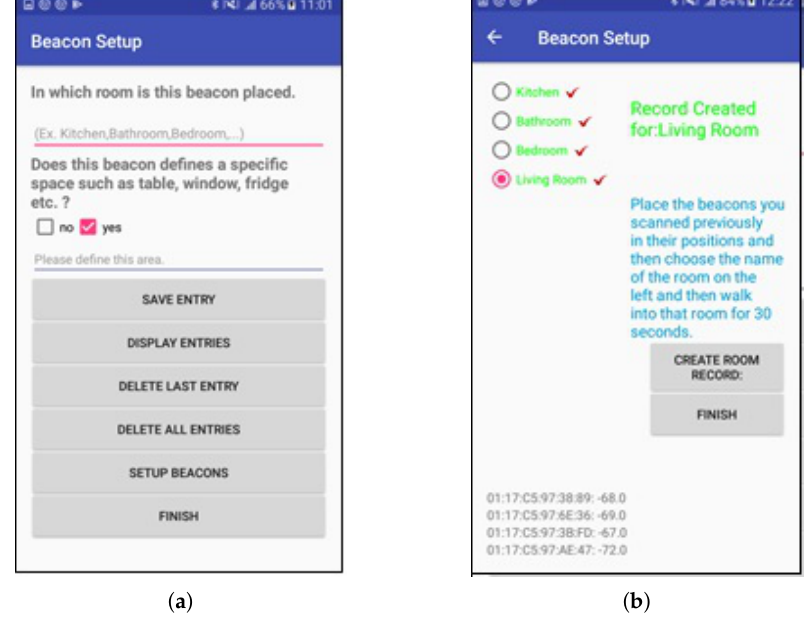
Figure 6. Screenshots from the Beacon Setup application ( a ): The user enters the names of the rooms one by one. ( b ): On the left there is a list of the rooms. Each time the user of the application chooses a room and performs a half minute walk in the specific